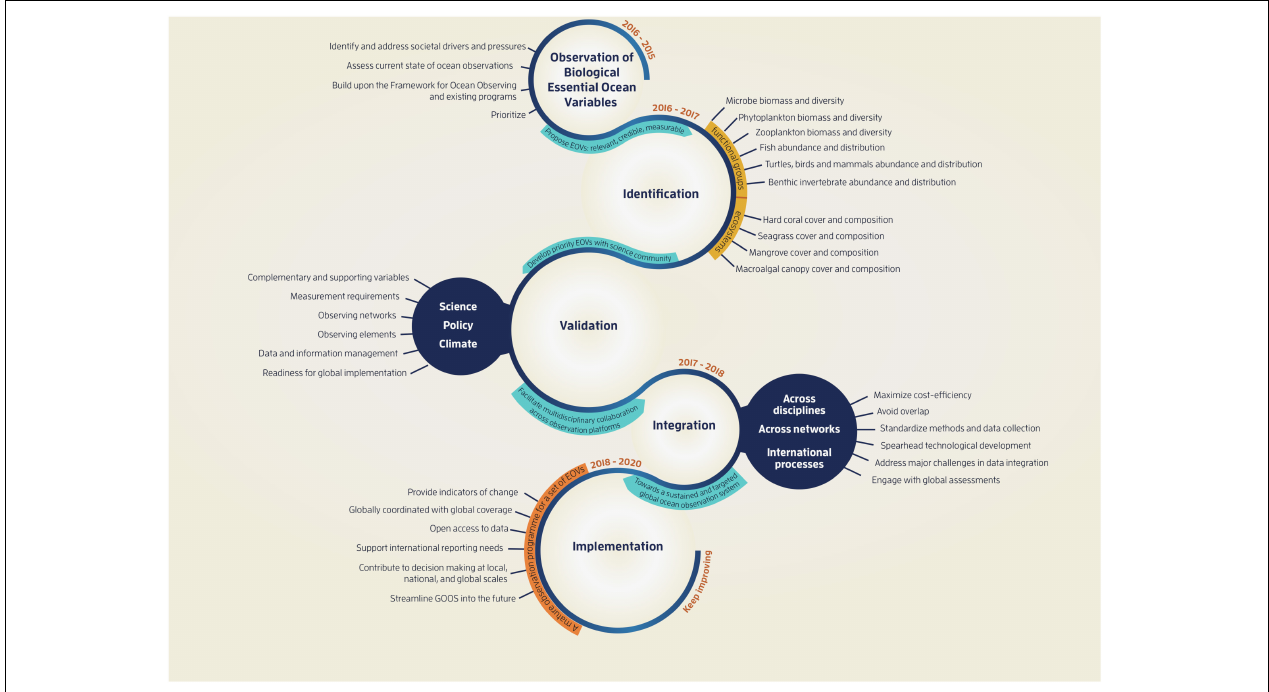
FIGURE 1 | Schematic of the tasks identified by the GOOS Biology and Ecosystems Panel to develop a sustained observing system.